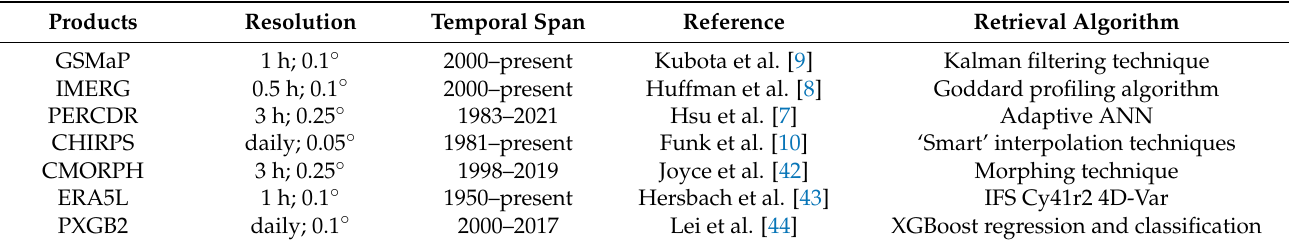
Table 1. The information of precipitation products used in this